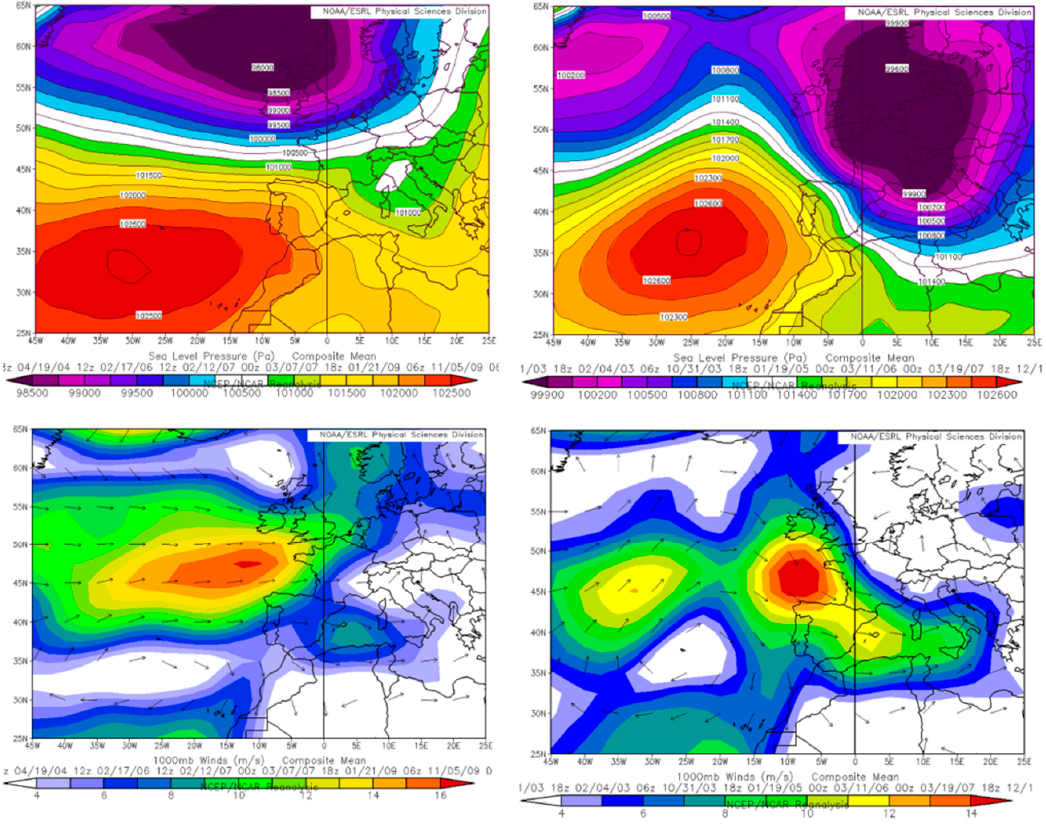
Figure 4. Composite sea level pressure ( upper row ) and wind ( lower row ) fields corresponding to wave storms belonging to Cluster 1 ( left column ) and Cluster 2 ( right column ). Image provided by the NOAA/ESRL Physical Sciences Division, Boulder Colorado from their Web site at http://www.esrl.noaa.gov/psd/.